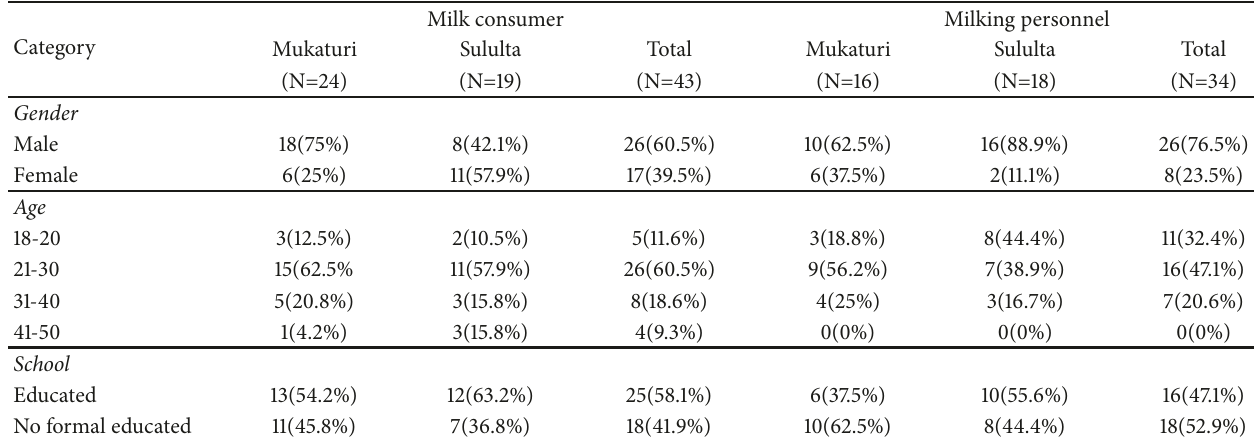
Table 1: General information of